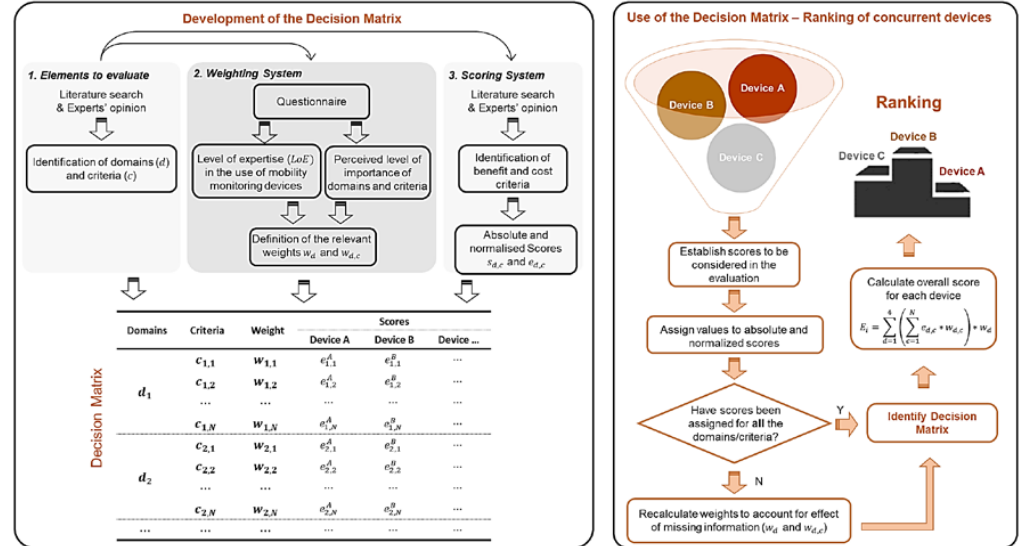
Figure 1. ( Left Panel ) Structure of the procedures required to identify the three elements that compose a decision matrix. LoE = level of experience in the use of wearable devices. ( Right Panel ) Visual representation of the use of the decision matrix for ranking different wearable devices.